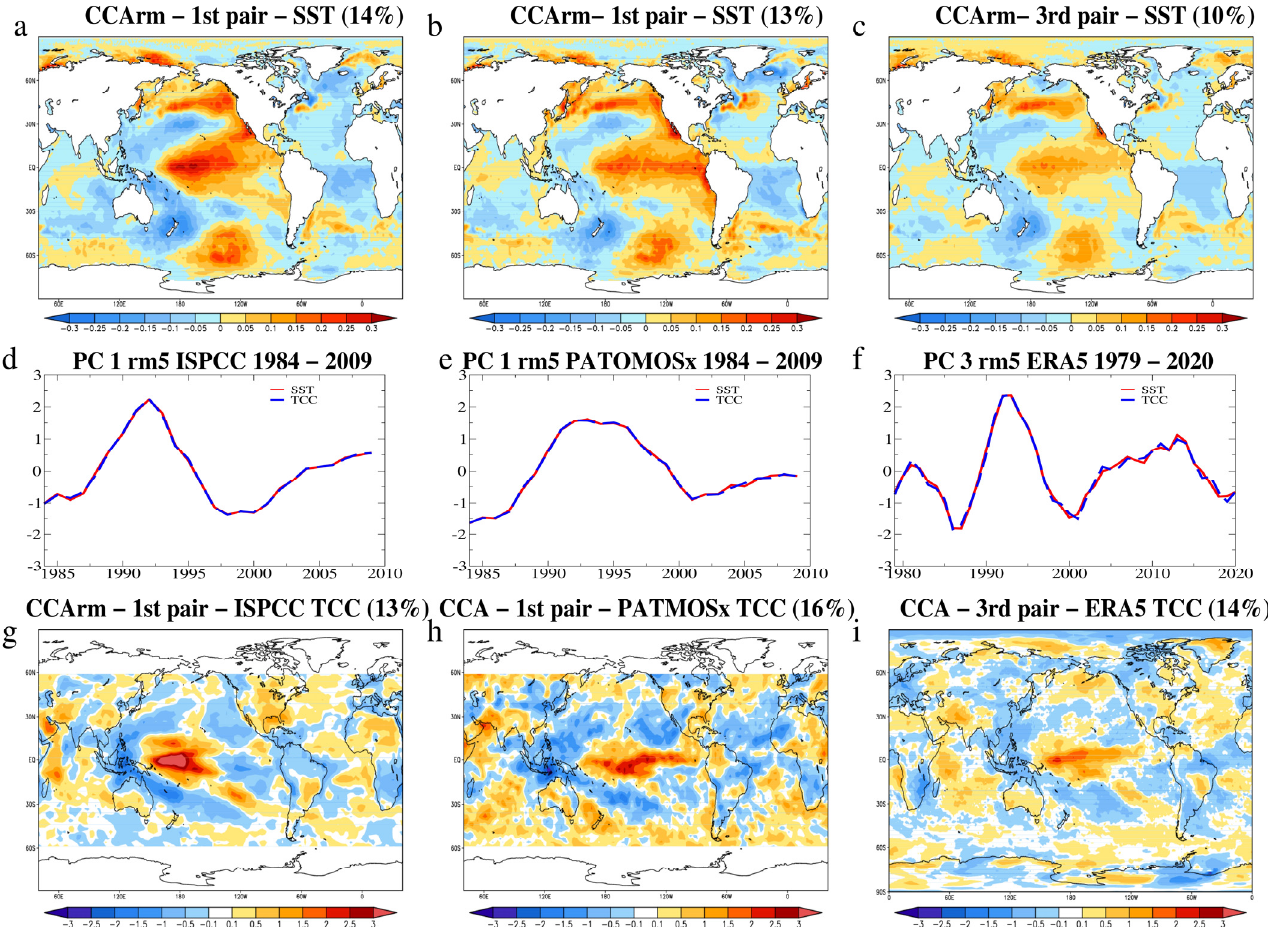
Figure 5. Pacific decadal SST variability footprint on global SST–TCC fields identified through CCA using ISPCC, PATMOS-x and ERA5 total cloud cover data filtered by a 5 yr mean. The left column shows the first coupled TCC (%)—SST (°C) pair identified through CCA using ISPCC TCC data, the SST pattern ( a ), explaining 14% of variance, the TCC structure ( g ), explaining 13% and the time series ( d ) associated with TCC (blue line) and SST (red line). The mid column shows the first coupled TCC (%)—SST (°C) pair identified through CCA using PATMOS-x TCC data, the SST pattern ( b ), explaining 13% of variance, the TCC structure ( h ), explaining 16% and the time series ( e ) associated with TCC (blue line) and SST (red line). The right column shows the third coupled TCC (%)—SST (°C) pair identified through CCA using ERA5 TCC data showing the SST pattern ( c ) explaining 10% of variance, the TCC structure ( i ) explaining 14% and the time series ( f ) associated with TCC (blue line) and SST (red line).